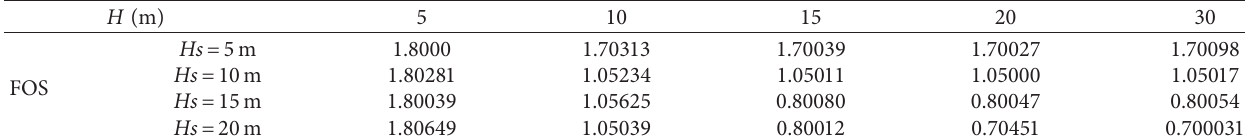
Table 2: Calculation results of FOS for deep foundation pit.